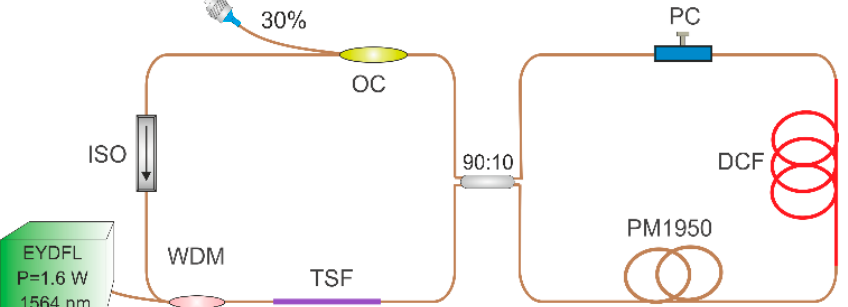
Figure 1. Experimental setup of the mode ‐ locked TDFL with NOLM; EYDFL—Er/Yb ‐ co ‐ doped ring fiber laser, WDM—1560/2000 wavelength division multiplexer, TSF—single ‐ mode thulium ‐ doped fiber, OC—output coupler, ISO—fiber optic isolator, PM1950—PM passive fiber, DCF—dispersion compensation fiber, PC—polarization controller.